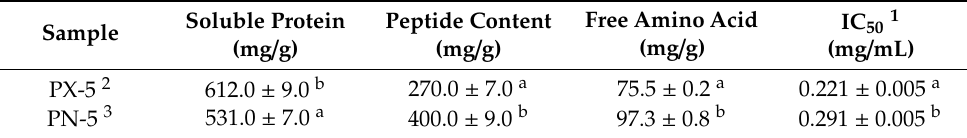
Table 1. Chemical compositions and ACE IC 50 of cobia skin protein hydrolysates.